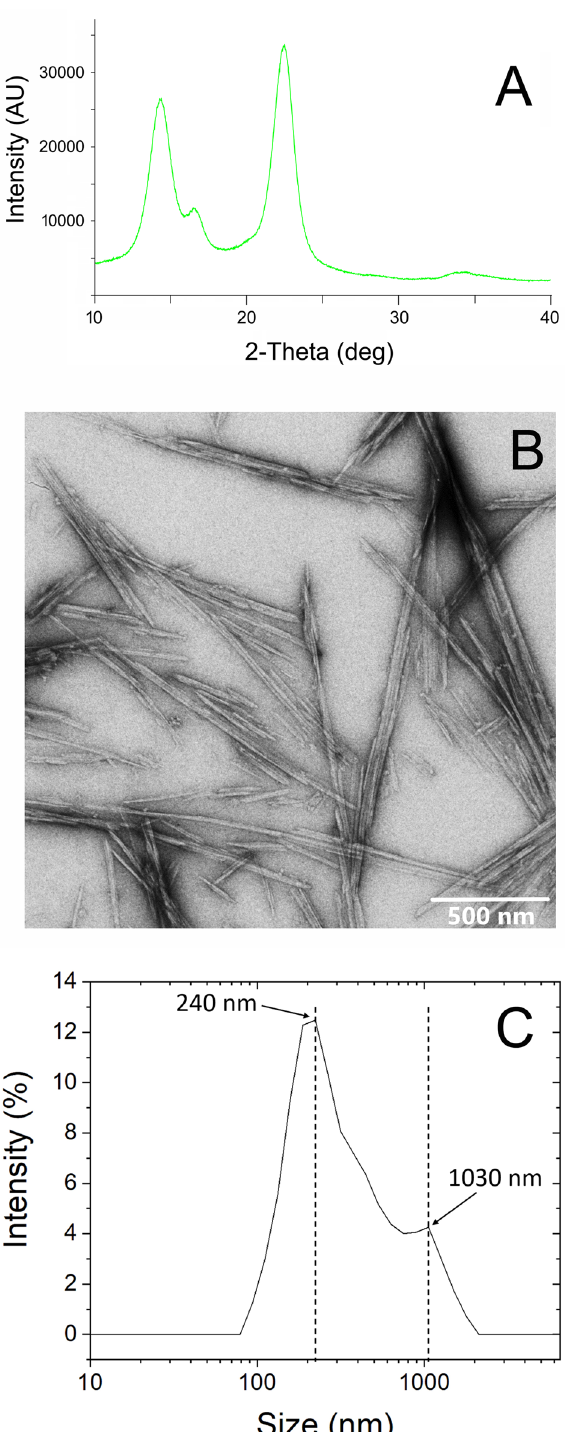
Figure 1. BCNCs production and characterization. ( A ): X-ray diffraction analysis of BC produced by K. xylinus DSM 2325; ( B ) transmission electron microscopy images of needle-like BCNCs; ( C ) dynamic light scattering size distribution analysis of